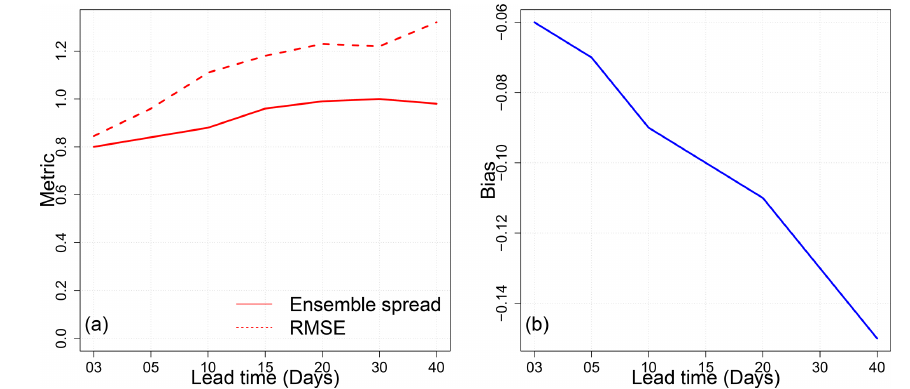
Figure 9. (a) Comparison between the ensemble spread and the RMSE. We note that the difference is small for short lead times ( ≤ 15d). “Metric” on the vertical axis refers to ensemble spread and RMSE. (b) The bias between the simulations and the observations for the lead times going from 3 to 40d.